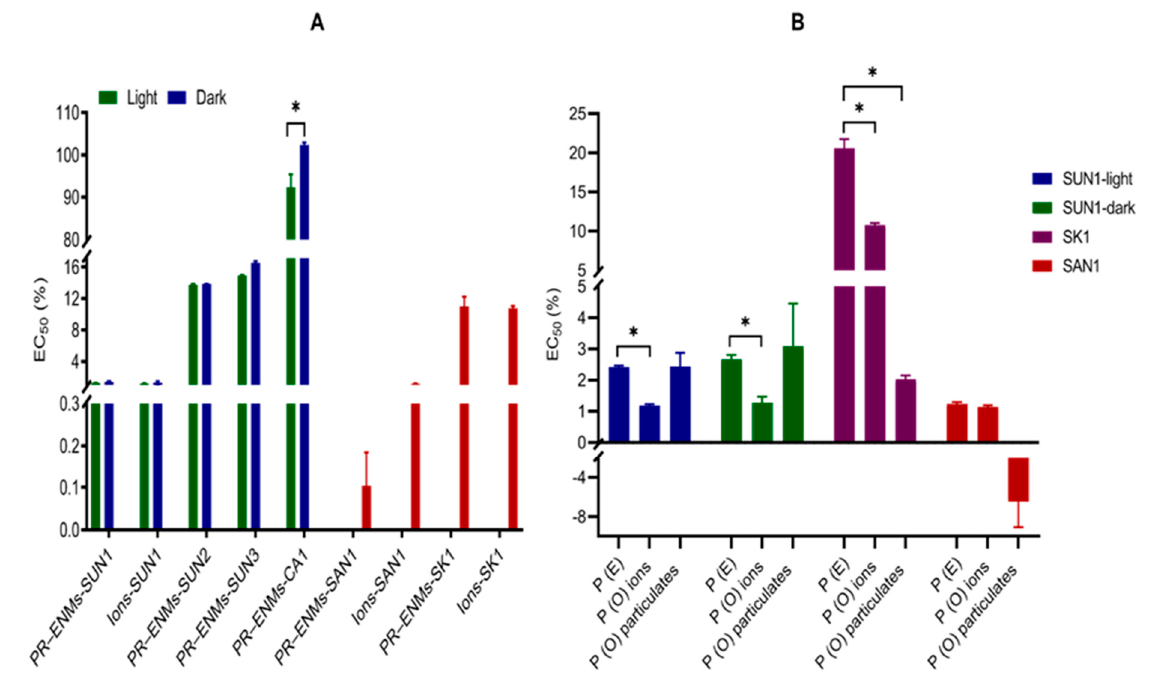
Figure 1. The 72 h EC 50 values of P. subcapitata exposed to PR-ENMs and ions ( A ), and comparisons between the modelled effects (P (E)) and observed effects (P (O)) of particulates and ions on P. subcapitata ( B ). * indicates a significant difference at p ≤ 0.05. The significant difference in ( A ) was investigated between PR-ENMs obtained under light and dark conditions.